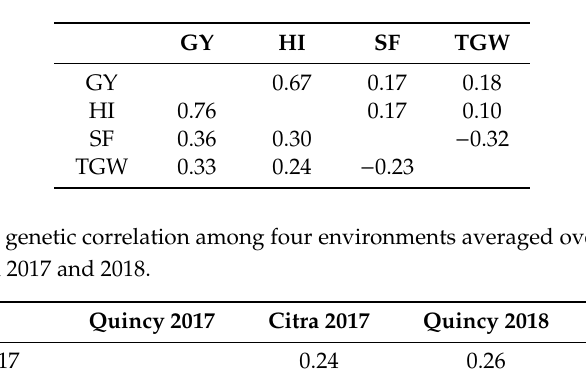
Table 3. Estimates of averaged genetic correlation (above diagonal) and Pearson correlation of phenotypic values (below diagonal) among GY (ton ha − 1 ), HI (%), SF (grains / g of cha ff weight), and TGW (g) across four environments.